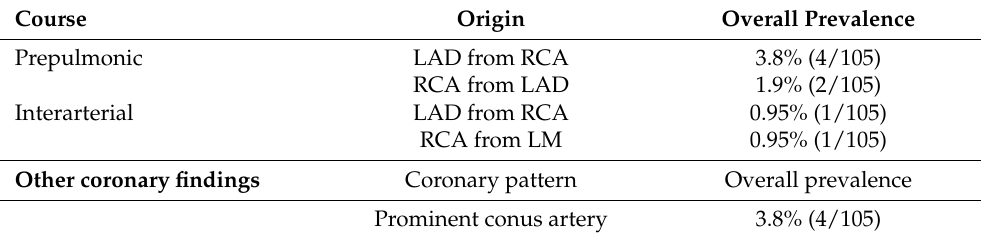
Table 2. Coronary artery anomalies and prominent conus